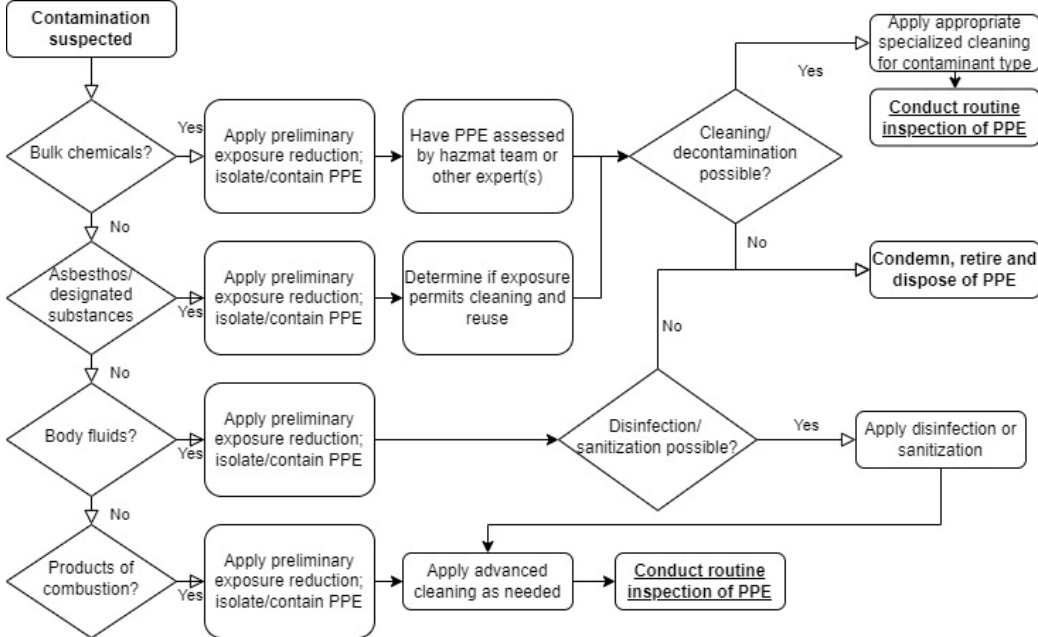
Figure 2. Approach for addressing specific types of contamination according to NFPA 1851 [29].